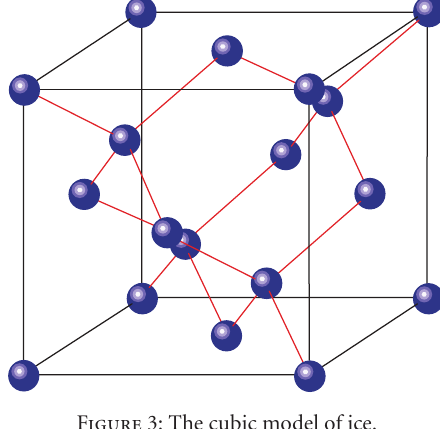
Figure 3: The cubic model of ice.